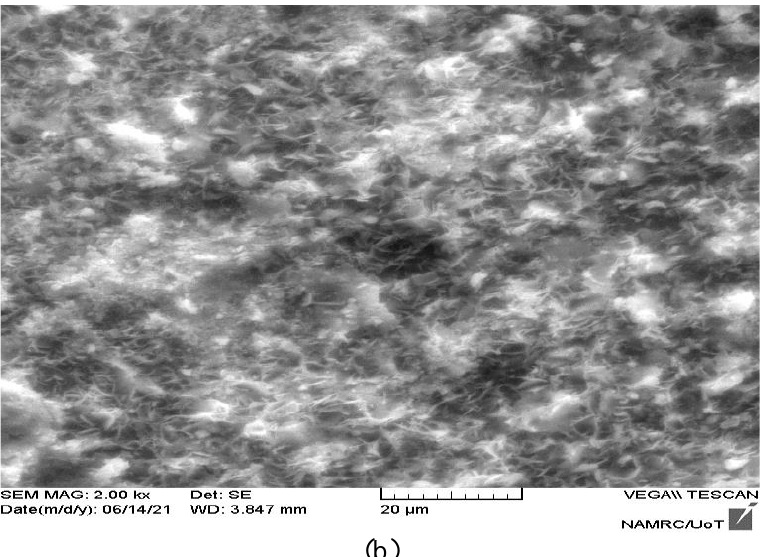
Figure 2(b): SEM image of 0.2gm/cm 3 of CdO thin film for pH=7.2.